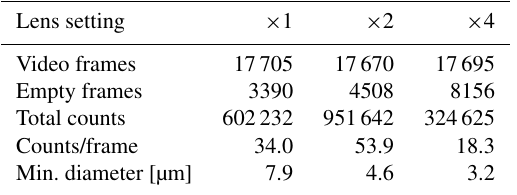
Table 3. Statistics of the laboratory experiment with polydisperse droplets for different lens magnification